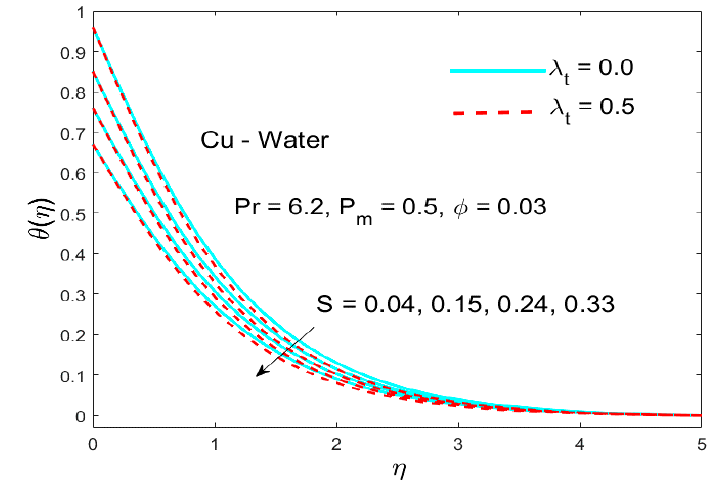
ff erent values of S